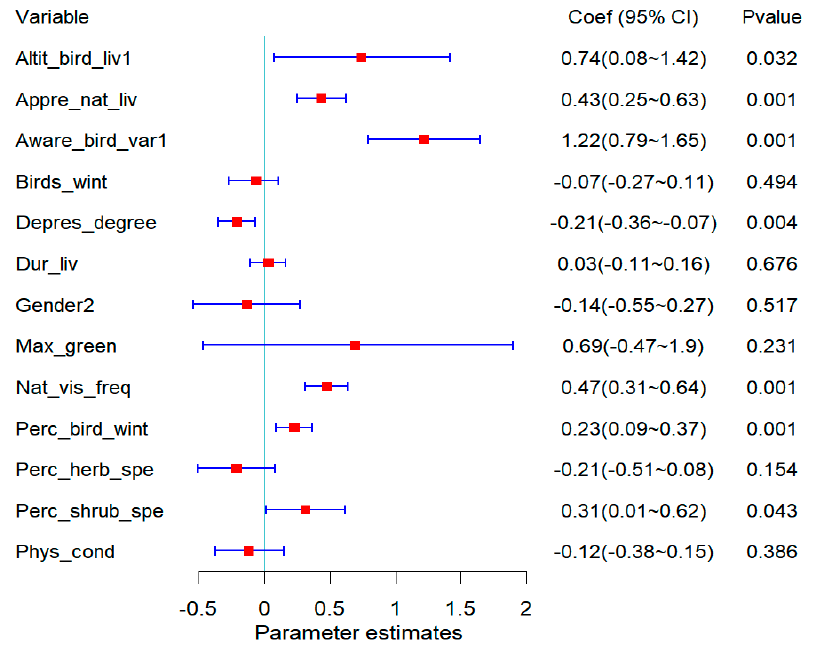
Figure 4. Logistic regression results for key factors promoting bird watching activity within the living spaces. The definition of the level for categorical variables can be found in Table